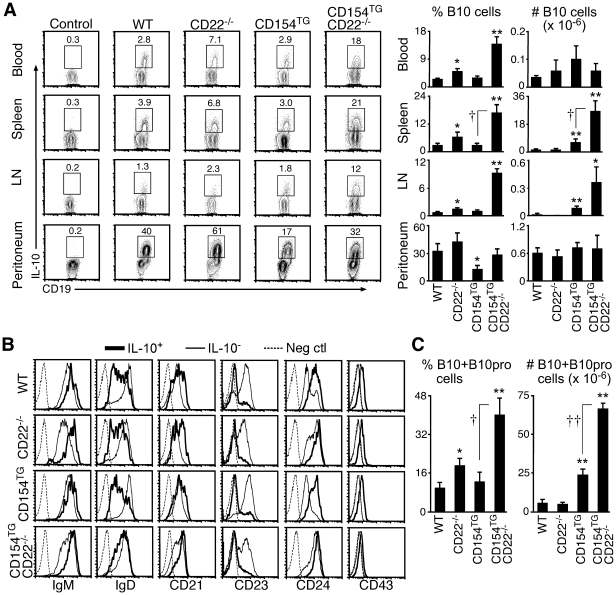
Spleen B10 and B10pro cells expand dramatically in CD154TGCD22−/− mice.(A) Blood, spleen, inguinal LN, and peritoneal cavity B10 cell numbers in WT, CD22−/−, CD154TG, and CD154TGCD22−/− mice. Leukocytes from the indicated tissues were cultured with LPS, PMA, and ionomycin for 5 h to induce IL-10 production, with monensin included in the cultures to block IL-10 secretion (L+PIM stimulation). The cells were then stained for cell surface CD19 and cytoplasmic IL-10 with flow cytometry analysis. Monensin treated cells served as negative controls for IL-10 expression. Representative contour plots gated on CD19+ cells are shown with the percentage of IL-10+ cells indicated. Bar graphs represent mean (±SEM) B10 cell frequencies (%) and numbers (#) from ≥3 mice of each genotype. (B) Similar B10 cell surface phenotypes among mouse genotypes. Splenocytes were cultured with L+PIM for 5 h and then stained for cell surface molecules and cytoplasmic IL-10. Histograms indicate cell surface molecule expression by IL-10+ (thick lines) and IL-10− (thin lines) B cells. Dashed histograms represent isotype-matched control mAb staining. Results are representative of ≥3 mice of each genotype analyzed. (C) Spleen B10+B10pro cell frequencies and numbers. Splenocytes were cultured with an agonistic CD40 mAb, with L+PIM added during the final 5 h of 48 h cultures. Cytoplasmic IL-10+ B cells were identified as in (A). Bar graphs show means (±SEM) from ≥3 mice of each genotype. (A,C) Significant differences from WT mice are indicated: *p<0.05, **p<0.01. Means significantly different between CD154TGCD22−/− and CD154TG mice are indicated: †p<0.05, ††p<0.01.